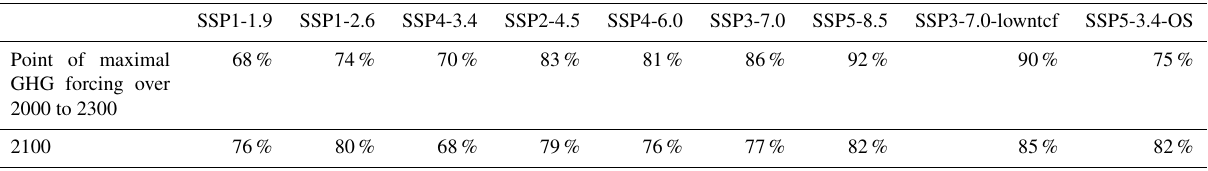
Table 6. Fraction of greenhouse-gas-induced forcing due to CO 2 concentrations in SSP scenarios at the point of maximal greenhouse-gas- induced forcing until 2300 (upper row) or in the year 2100 (lower row).